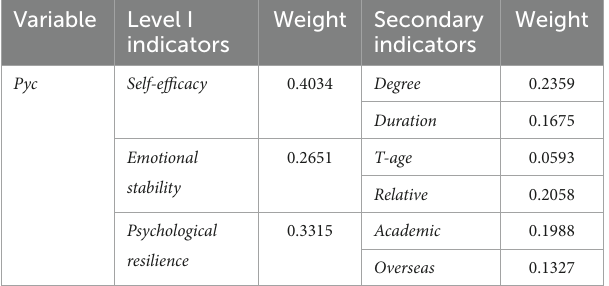
TABLE 1 Index system of senior executives’ psychological capital.